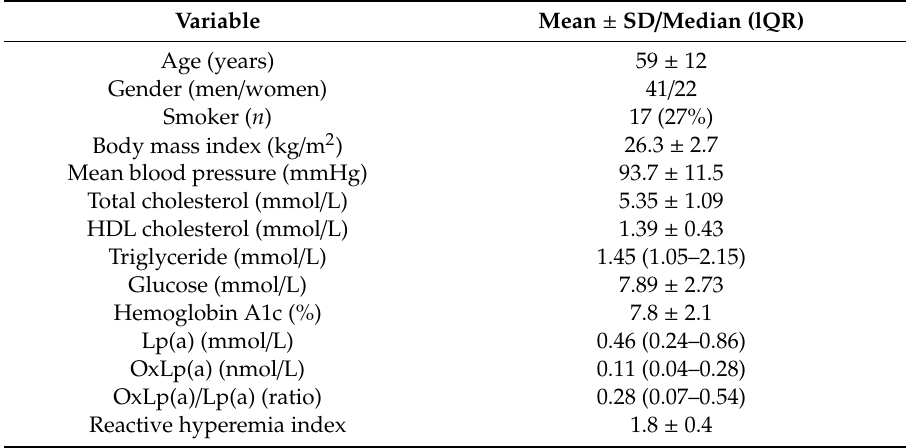
Table 1. Clinical